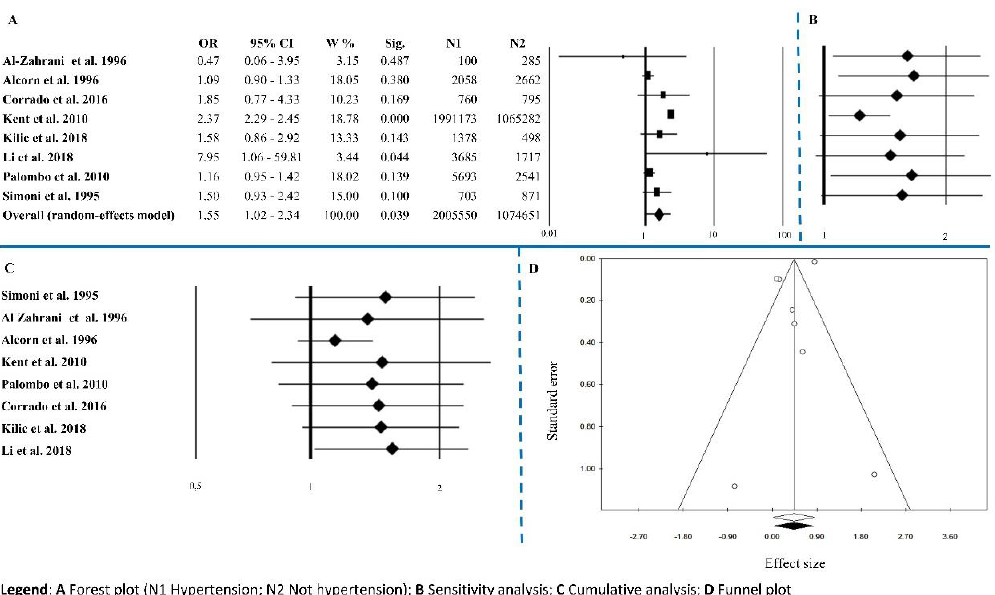
Figure 4. Hypertension. ( A ) Forest plot (N1 Hypertension; N2 Not hypertension); ( B ) sensitivity analysis; ( C ) cumulative analysis; ( D ) funnel plot.